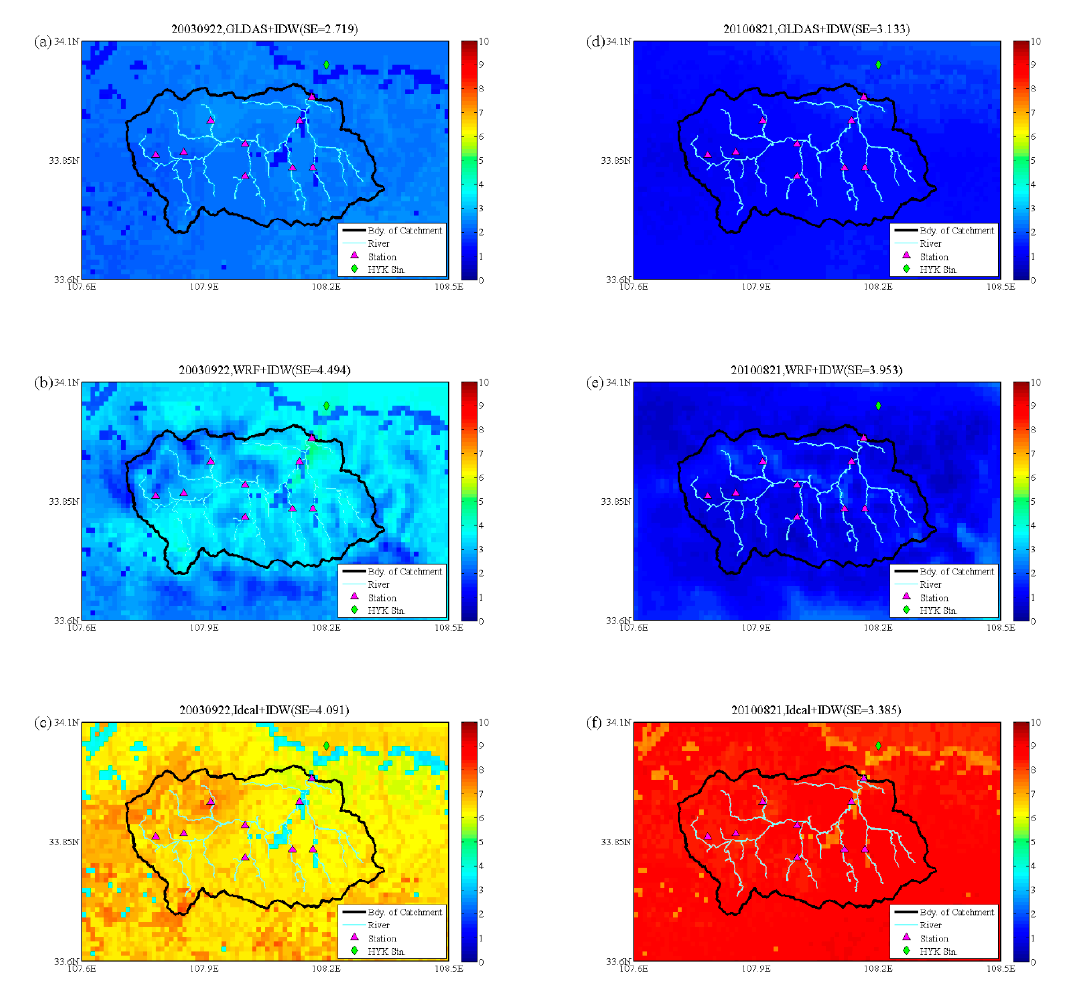
Figure 9. Spatial distribution of simulated ET on the highest observed ET day in scenarios G + I, W + I and I + I from top to bottom in terms of 030916, ( a )–( c ), and 100820, ( d )–( f ). The pink triangle represents rainfall/discharge station and green diamond represents HYK Station. (Unit:mm).